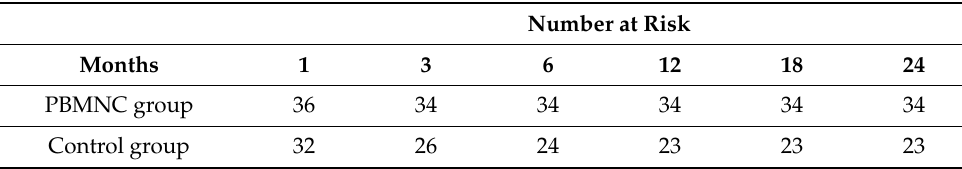
Figure 2. Amputation-free survival: the number of patients alive without amputation in both groups during the follow-up period (1–24 months).